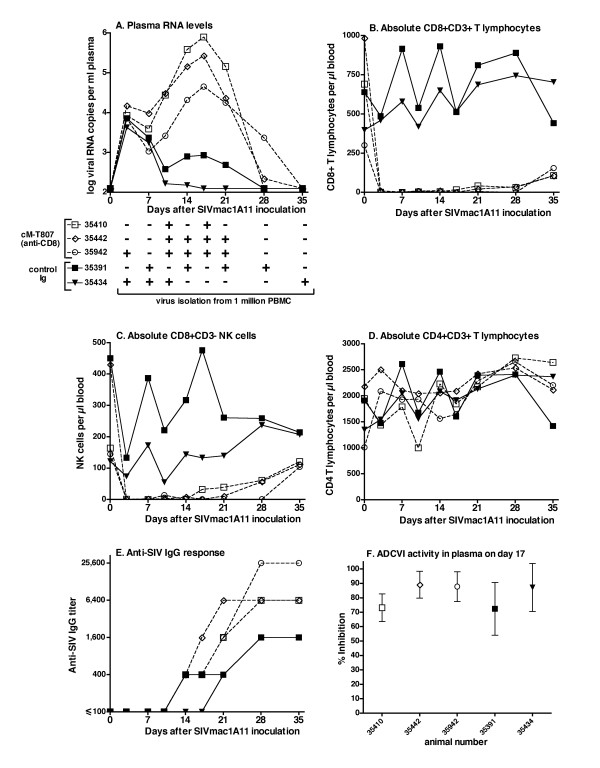
Effect of CD8+ cell depletion on SIVmac1A11 infection: viral and immunologic parameters. Five animals were inoculated with SIVmac1A11 at time zero. Three animals were CD8+ cell depleted via administration of cM-T807 while the other 2 animals received control antibody. (A) Viral RNA levels in plasma (measured by bDNA assay, with a limit of detection of 125 copies/ml; [18]). Results from virus isolation from 1 million PBMC, using CEMx174 cells and p27 measurement [34] are given as positive (+) or negative (-). The absolute counts of CD8+CD3+ T lymphocytes, CD8+CD3- NK cells and CD4+CD3+ T lymphocytes were measured according to flow cytometry techniques described previously [18], and are presented in graphs B through D, respectively. (E) SIV-specific IgG titers measured by a whole SIV ELISA [29]; although the CD8+ cell depleted animals made a faster response than the undepleted animals, from week 6 onwards, both animal groups had similar antiviral IgG titers (1: 6,400 to 1: 25,600). (F) Antiviral activity of plasma collected at 17 days after SIVmac1A11 inoculation as measured in a ADCVI assay, described in detail elsewhere (Forthal et al., submitted for publication). Briefly, CEMx174 cells were infected with SIVmac1A11 at a MOI of 0.01; 48 hours later, cells were plated in 96-well plates at 50,000 cells per well. Plasma samples (including negative and positive control samples) were added at a 1:100 dilution and human PBMC effector cells were added to obtain an effector:target cell ratio of 10:1. Five days later, SIV p27 was measured in supernatant fluid using a commercially available ELISA (Zeptometrix Corporation, Buffalo, NY). Percent inhibition by the plasma samples collected on day 17 was calculated relative to the level of virus replication in the presence of plasma collected on day zero (before SIVmac1A11 inoculation); the presented values represent mean +/- SEM of 4 separate assays (with effector PBMC of 4 different donors). In the absence of effector cells, no significant inhibition (≤ 11%) was observed (data not shown).